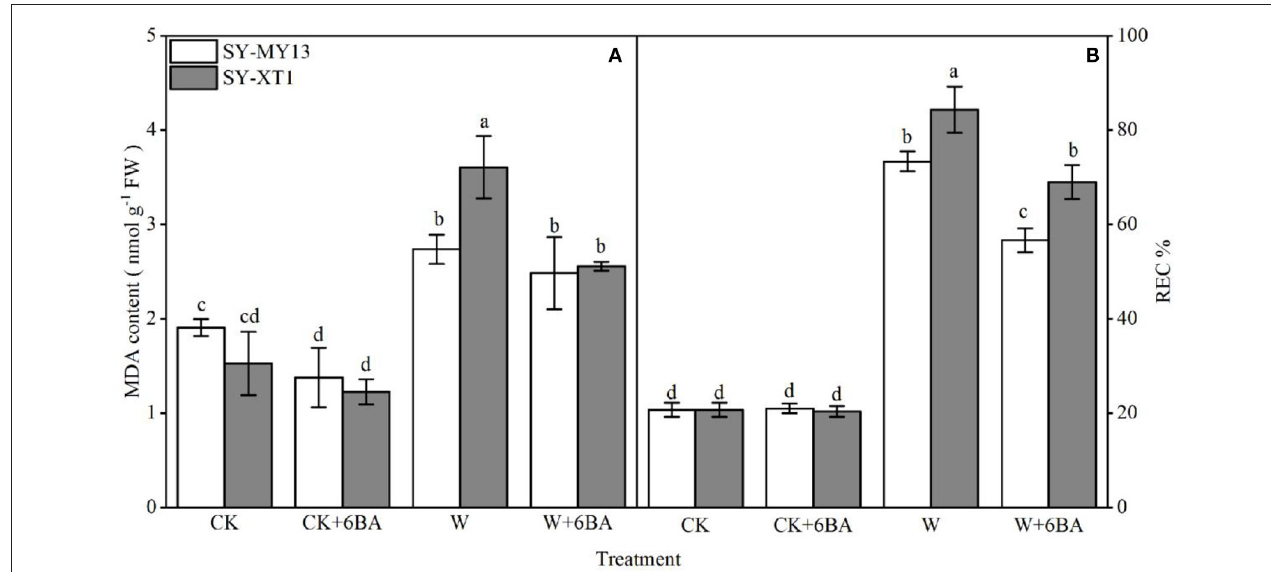
FIGURE 3 | Effects of 6-BA on malondialdehyde (MDA) concentration (A) and relative electric conductivity (REC%) (B) in two waxy corn inbred lines experiencing waterlogging. CK, normal watering conditions only; CK + 6-BA, 0.5mM of 6-BA plus normal watering conditions; W, waterlogged; W + 6-BA, addition of 0.5mM of 6-BA plus waterlogging stress conditions. Data represent means ± SD of three replicates. For each variable, means with different lowercase letters were significantly different ( P <